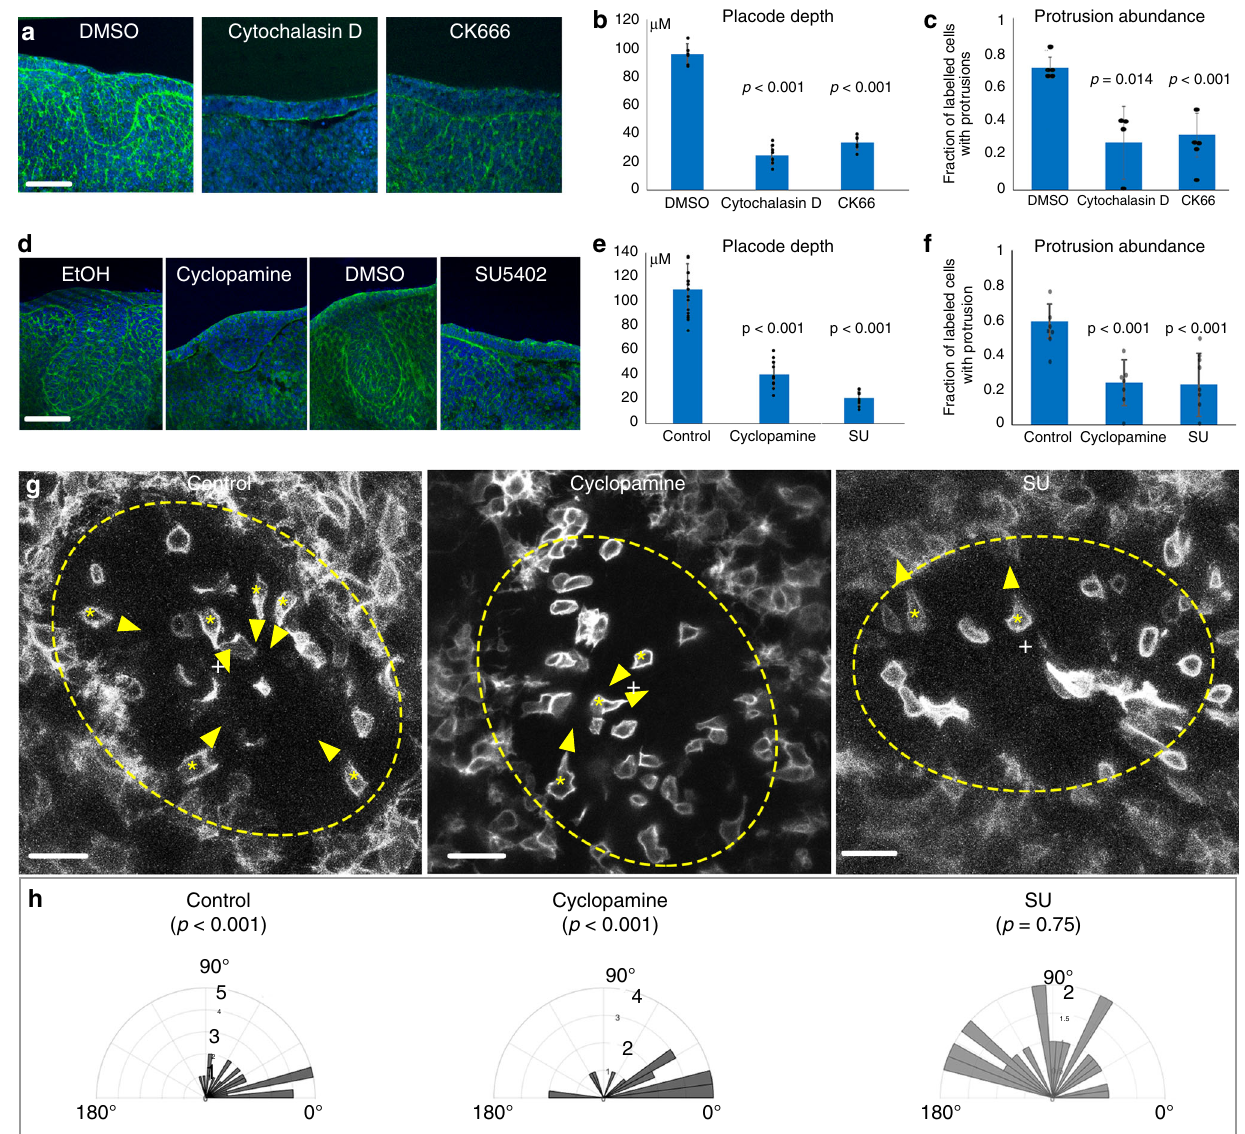
Fig. 4 Protrusions and invagination are similarly sensitive to inhibitors. a , d Transverse sections of SG placode explant culture with DMSO (vehicle), Cytochalasin D, CK666, ethanol (vehicle), cyclopamine, or SU5402, as indicated (green: phalloidin; blue: DAPI) showing inhibition of invagination. Scale bars: 50 μ m. b , c , e , f Quanti fi cation of placode depth ( b , e ) and protrusion abundance ( c , f ) in inhibitor-treated placodes vs. vehicle-treated controls (means±SDs, n = 12 placodes, 4 placodes per treatment per experiment from 3 independent litters; n = 100 cells, ~8 per placode). c , f Quanti fi cation of by inhibitors compared to controls, g top-view live images of SG placodes in mT/mG explants treated with vehicle, cyclopamine or SU5402. Dashed line circles: placode region. Asterisks inside cells: the cell bodies of protrusive cells. Arrowheads: direction of the protrusion. “ + ” : the centre of the placode. Note that protrusions are centripetal in control and cyclopamine treated tissues, but not in SU5402-treated tissue. Only isolatedly labelled cells were analysed. Scale bars: 20 μ m. h Orientation of protrusions in the three treatments (0° indicates centripetal) (data from three independent litters, six placodes in each condition). p Values in b , c, e , f are from two-tailed unequal variance t tests, in ( h ) are Rayleigh test. Source data are provided as a Source Data fi